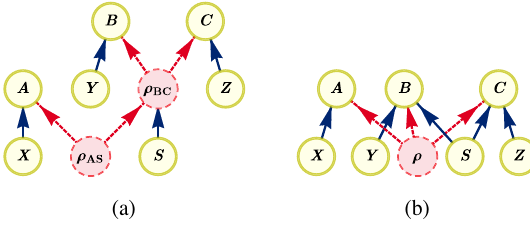
FIG. 8. In (a), there is a causal structure with ρ BC being a nonexogenous unobserved quantum node. In (b), there is a different causal structure, corresponding to the classical latent reduction of the former. While these two graphs are equivalent if the unobserved nodes are classical, they are demonstrably inequivalent when the unobserved nodes are quantum.